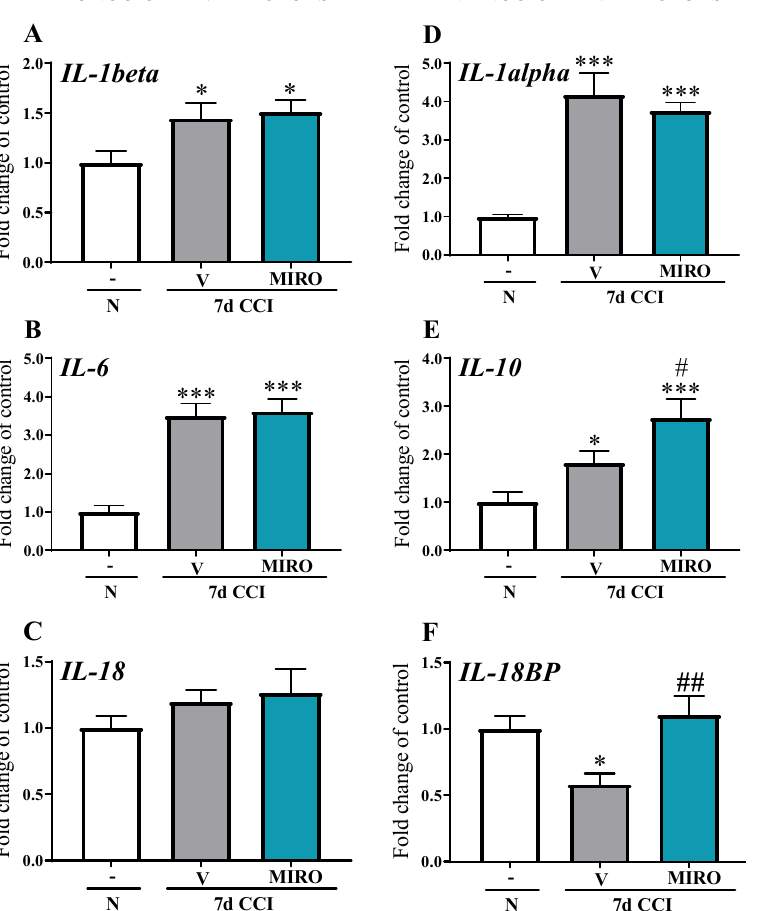
Figure 5. Effect of repeated intraperitoneal ( i.p. ) administration of mirogabalin (MIRO; 20 mg/kg) on IL-1beta ( A ), IL-6 , ( B ), IL-18 , ( C), IL-1alpha ( D ), IL-10 ( E ), IL-18BP ( F ) mRNA levels in the spinal cord on day 7 post-CCI in mice. The data for the biochemical studies were analysed as fold changes compared with the controls and represent the normalized averages derived from the RT–qPCR threshold cycles of 4 ‒ 10 samples from each group. Intergroup differences were analysed based on one-way ANOVA with Bonferroni’s multiple comparisons post hoc test. * p < 0.05; *** p < 0.001 indicate a significant difference compared with the naïve group, # p < 0.05, ## p < 0.01 indicate differences between the V- and MIRO-treated CCI-exposed mice. Abbreviations: N—naïve, V—vehicle; MIRO—mirogabalin.